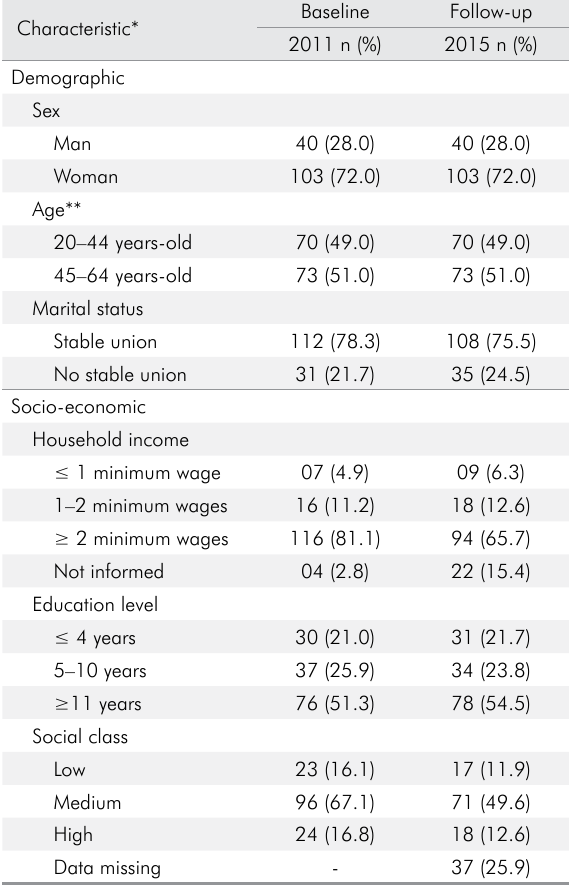
Table 1. Demographic and socioeconomic characteristics at baseline and follow-up of adults living in Piracicaba, SP, Brazil,